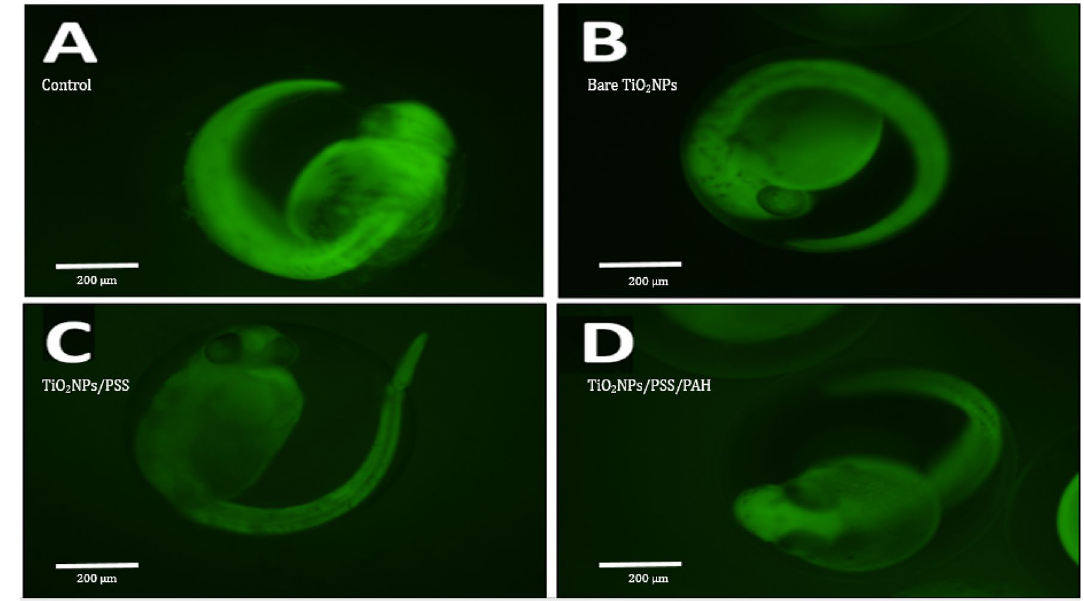
Fig. 2 FDA live/dead assay applied to D. rerio embryos (at 48–72 hpf, n = 5) exposed to different types of TiO concentrations of 1000 mg/L for each media and under visible